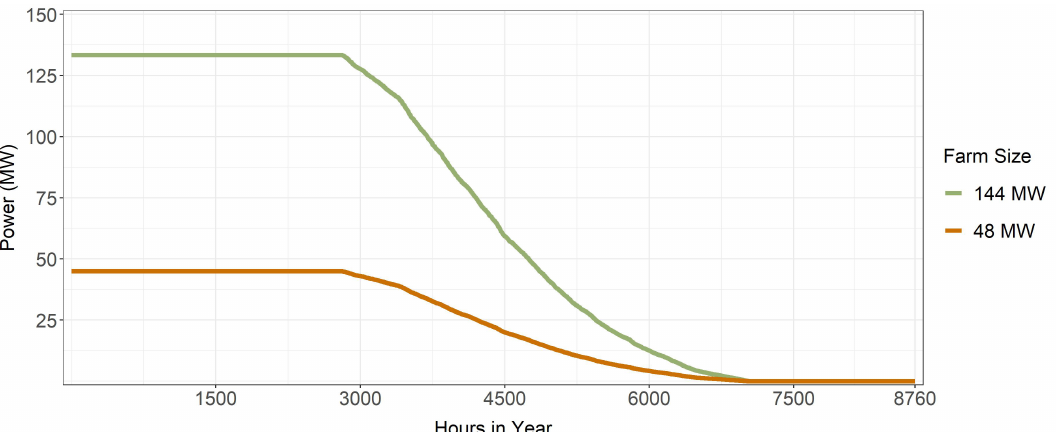
Figure 9. Generation duration curves for 48 MW and 144 MW farms. The 1836 MW development curve has the same shape but is omitted from this chart because it has a much larger power scale.